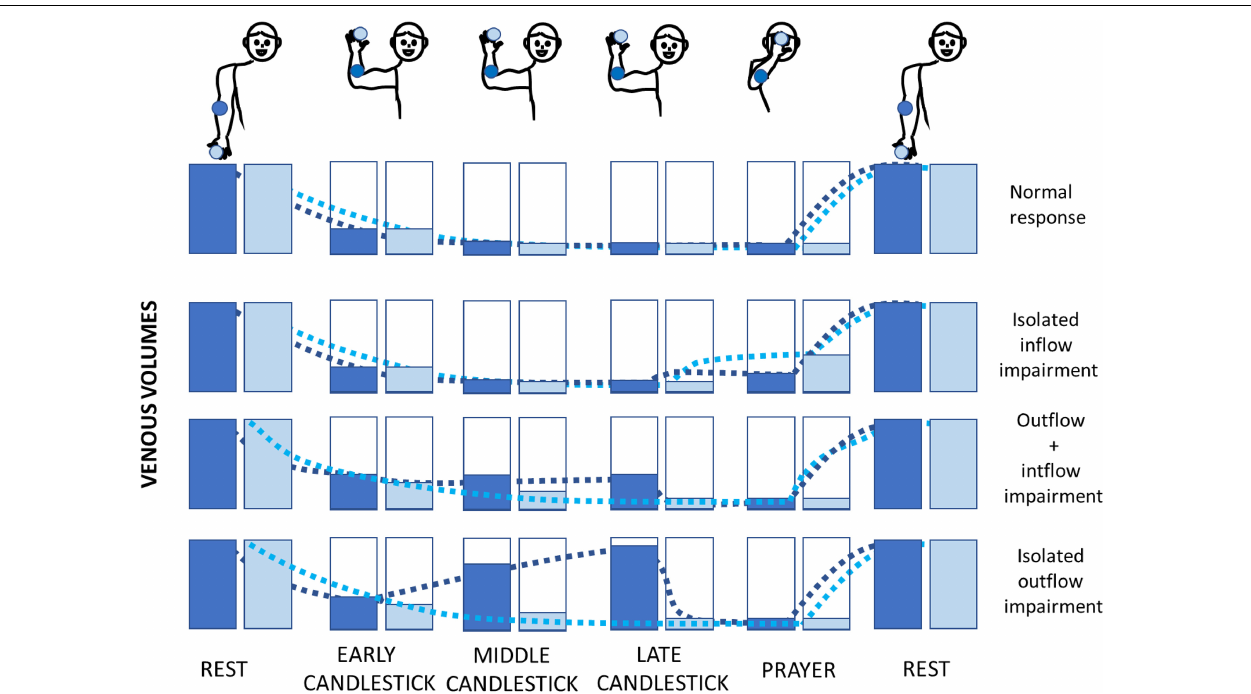
FIGURE 4 | Schematic representation of the hypotheses of the fingertip (light blue) and forearm (dark blue) volume changes during the Ca + Pra maneuver. Normally, the forearm and fingertip volumes decrease with arm elevation, and refilling will only occur during arm lowering (upper figure). In case of ischemia (isolated inflow impairment), it is expected that the decrease in adrenergic tone due to postischemic vasodilation would be better observed distally (at the fingertip level). If simultaneous inflow and outflow impairments occur, emptying of the forearm is stopped while fingertip veins may drain into the forearm veins due to hydrostatic pressure. Emptying of the forearm will be completed during the prayer attitude. In cases of isolated venous outflow impairment, arterial inflow during the candlestick attitude will fill the forearm from bottom to top (as in a filling bottle) and will increase the volume at the forearm far before the fingertip volume increases. It is noted that fingertip volume would increase too if the duration of the candlestick attitude was long